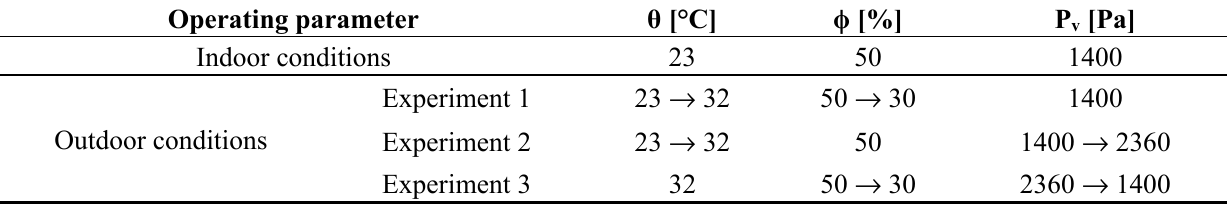
Table 2. Measurement strategy for non-isothermal, steady-state